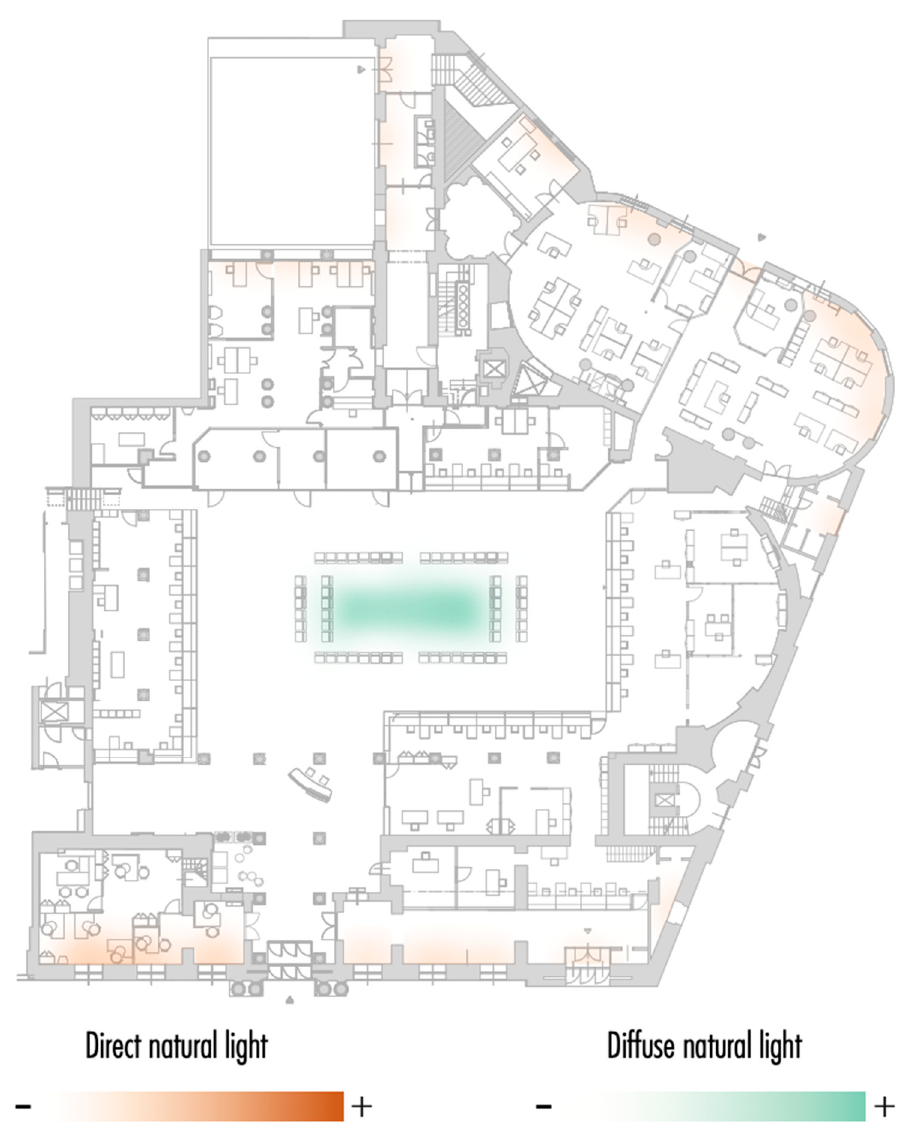
Figure 2. Diagram of light distribution before restoration.